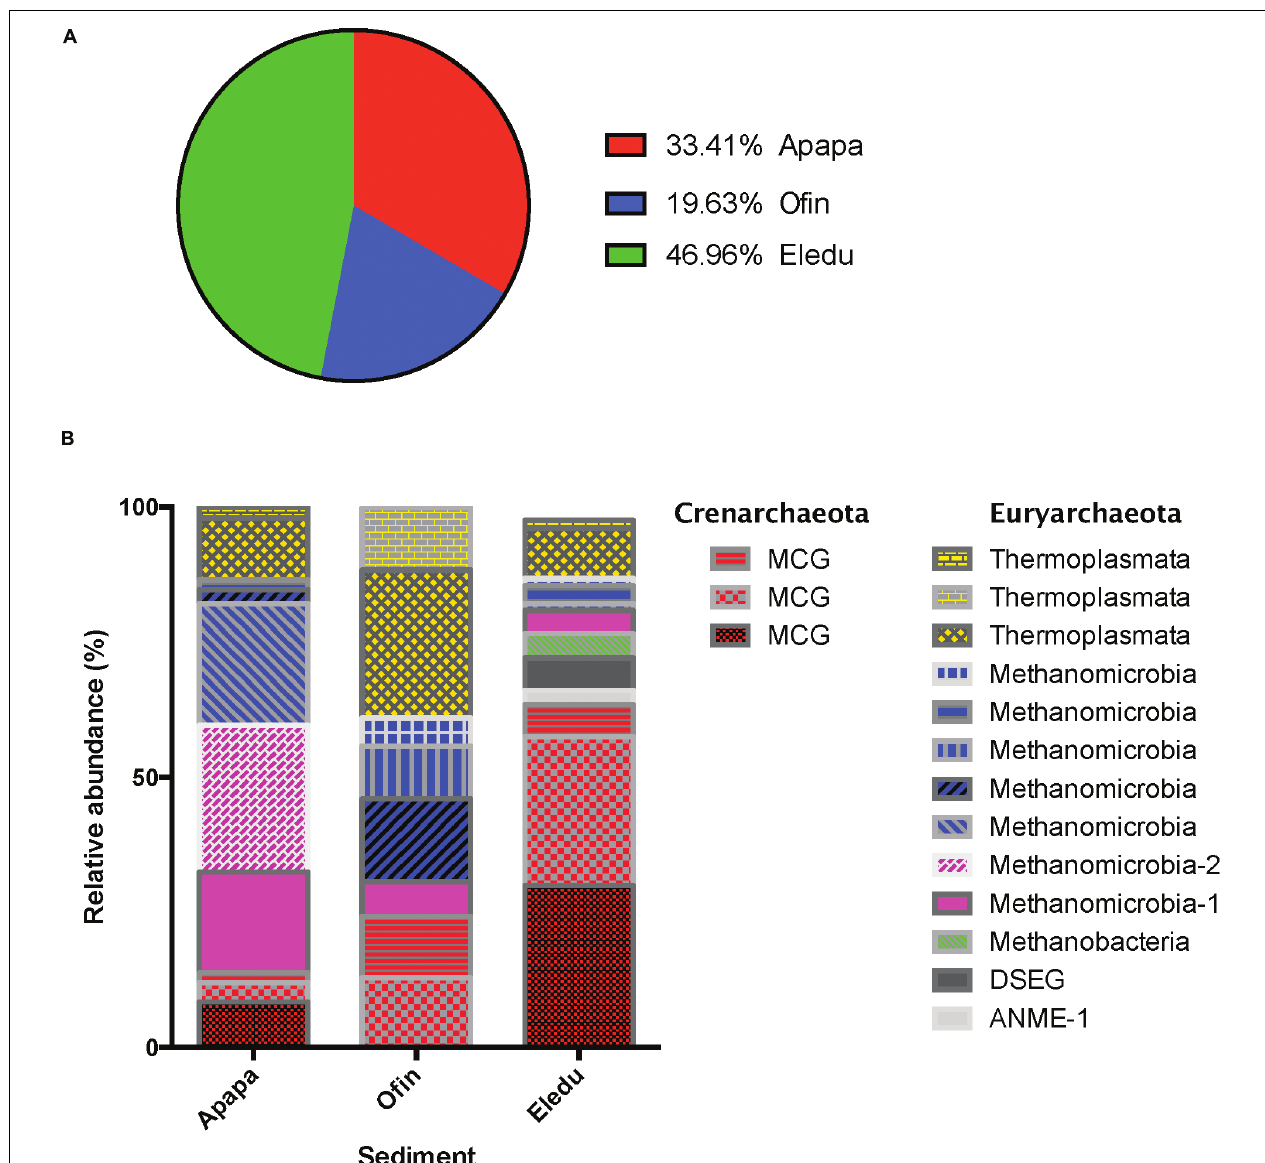
FIGURE 4 | Details of the archaeal community characteristics in the sediments. (A) Relative abundance of archaeal quality-filtered amplicons in each of the sediments as a percentage of the total archaeal quality-filtered amplicons across all libraries. (B) Relative abundance of major archaeal taxa in each of the sediment communities as a percentage of all archaeal quality-filtered amplicons in the indicated sediment. Abbreviations are: MCG, Miscellaneous Crenarchaeaotal Group; ANME-1, Anaerobic Methanotrophic-1; DSEG, Deep Sea Euryarchaeotal